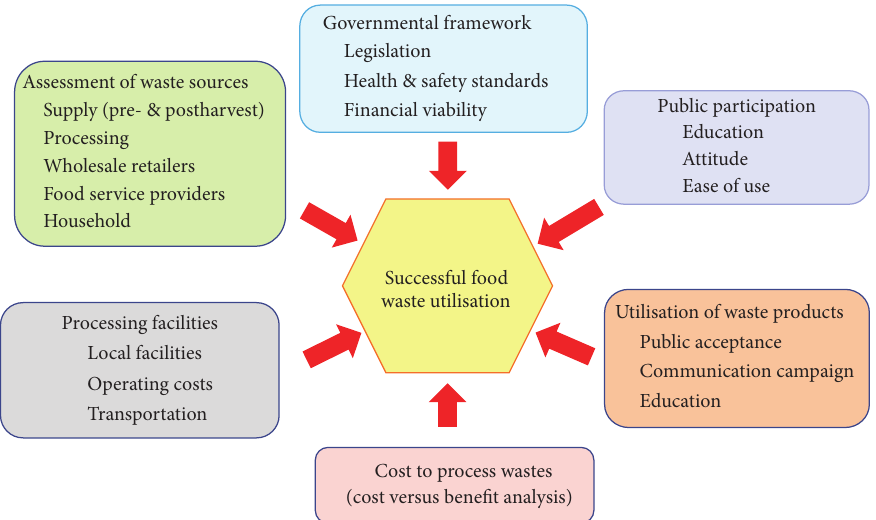
Figure 7: Important factors that need to be considered for successful utilisation of a food waste based